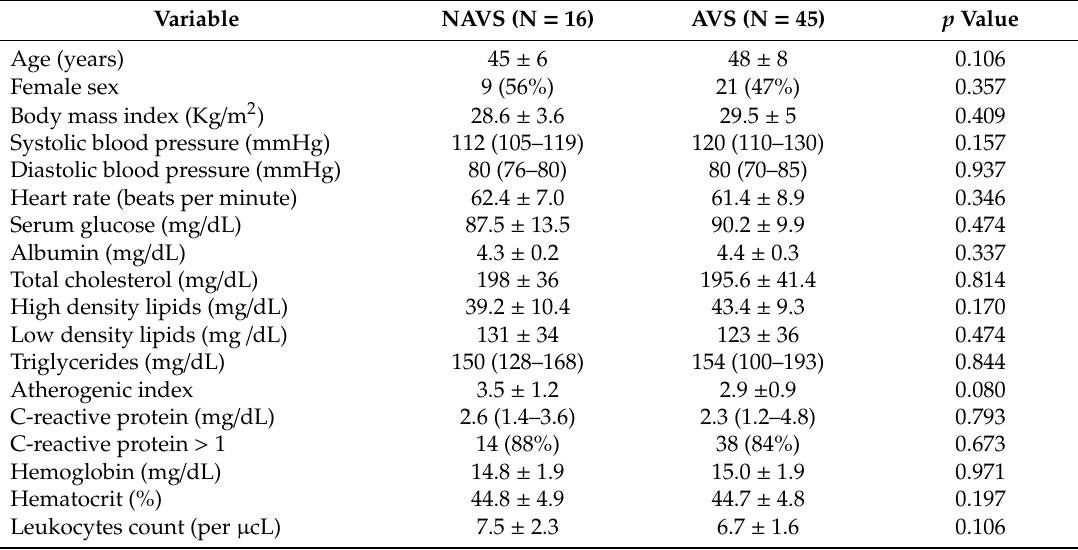
Table 1. Anthropometric and clinical characteristics. Data are shown as absolute value (percentage), mean ± standard deviation or median (percentile 25–percentile 75).